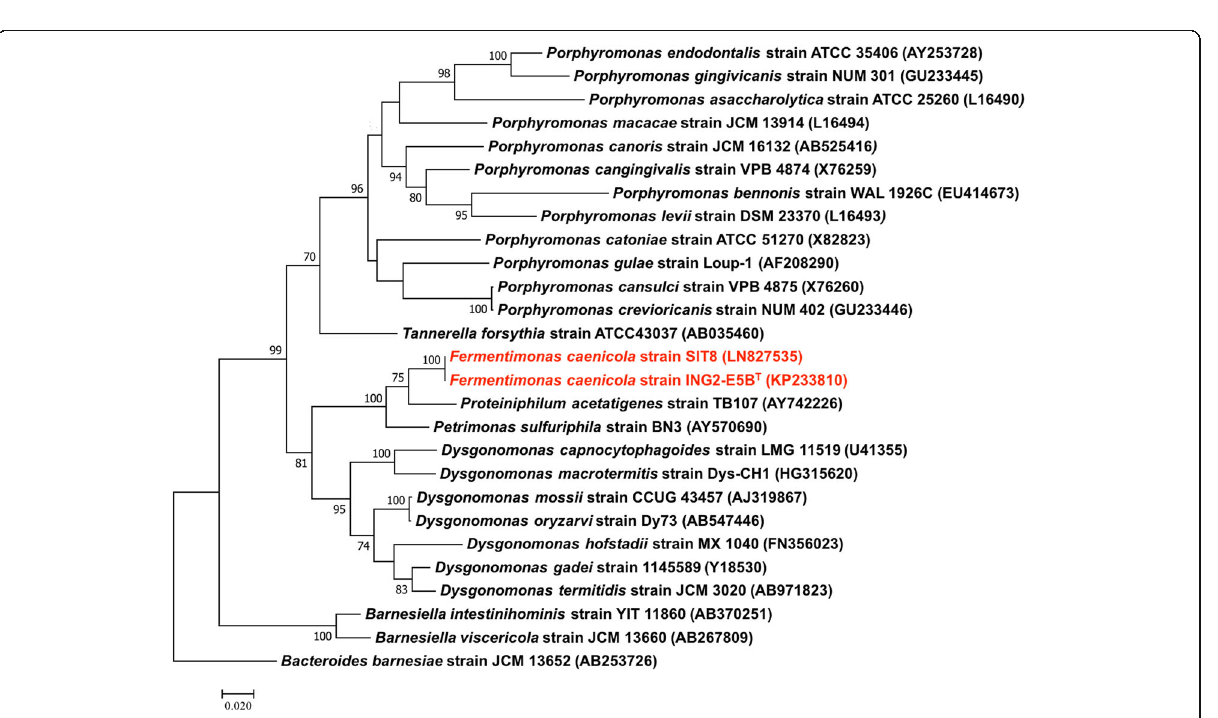
Fig. 2 Phylogenetic tree showing the position of Fermentimonas caenicola strains SIT8 and ING2-E5B T (red) relative to other phylogenetically close members of the family Porphyromonadaceae . GenBank Accession numbers are indicated in parentheses. Sequences were aligned using MUSCLE, and phylogenetic inferences were obtained using the maximum-likelihood method within the MEGA software [20]. Numbers at the nodes are percentages of bootstrap values obtained by repeating the analysis 1000 times to generate a majority consensus tree. Only values ≥ 70% were displayed. The scale bar indicates a 2% nucleotide sequence